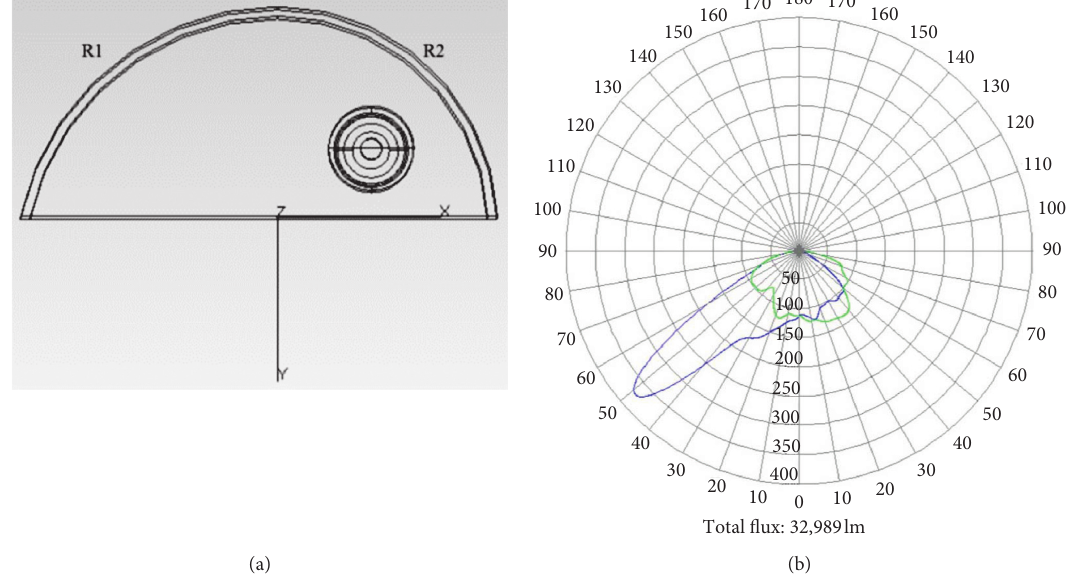
Figure 10: (a) The side view of the the new counterbeam light before optimization; R1 and R2 are the surface radius of the light. (b) The simulated intensity distribution of the new counterbeam light before